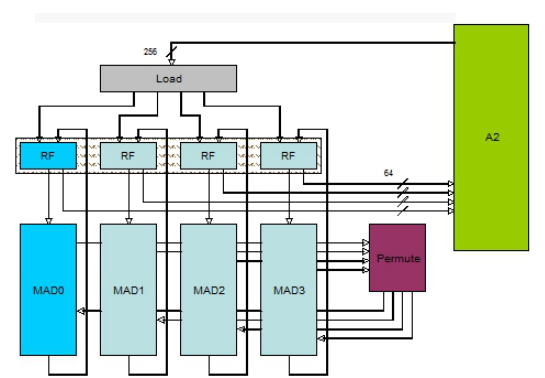
Figure 2. Quad FPU in each BlueGene/Q Core [3]